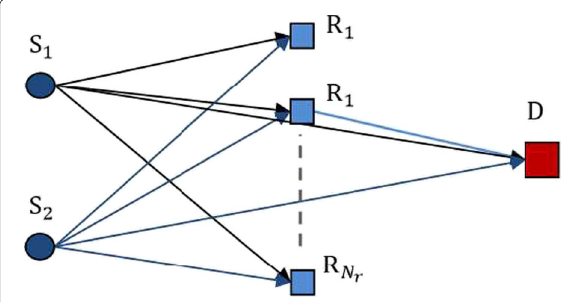
Fig. 1 Considered system consists of two sources: multiple relays and one